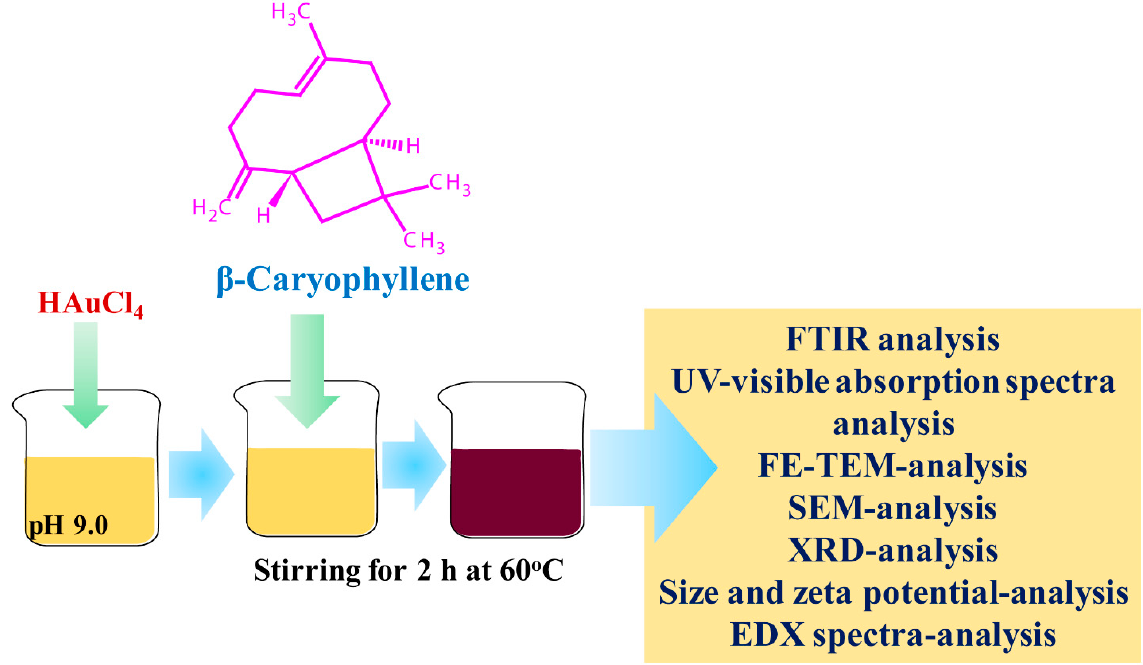
Figure 1. Steps employed in the synthesis and characterization of β -c-AuNPs.